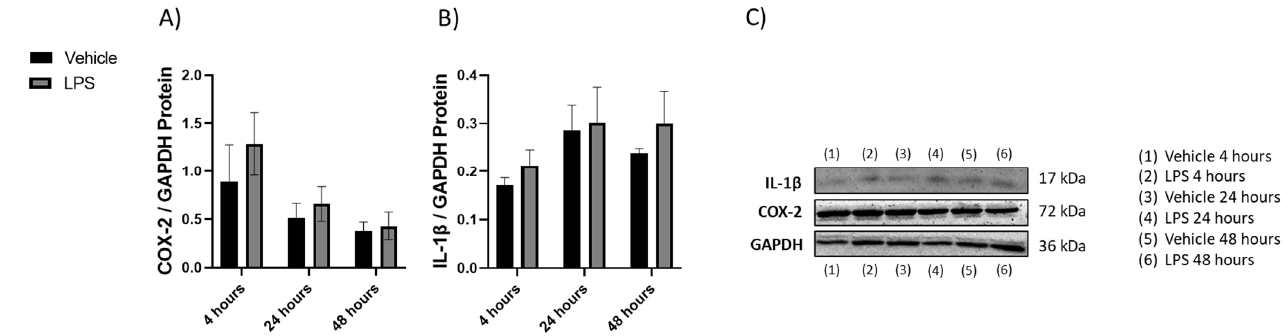
Figure 2. The effect of LPS and vehicle treatments on expression of COX-2 and IL-1 β in 4, 24, and 48 h time points. Figures represent changed protein expression for selected genes measured by West- ern blot. Glyceraldehyde-3-phosphate dehydrogenase (GAPDH) was used as a loading control. Rel- ative densitometry is presented as a ratio to GAPDH. ( A ) COX-2 expression, ( B ) IL-1 β expression, ( C ) representative images blots with each protein detected. Original membranes can be seen in Fig- ures S3–S5. Multiple t -tests were performed with a false discovery rate correction (Q = 5%, n = 3). The samples for each protein were run on the same gel. No image enhancements were applied.